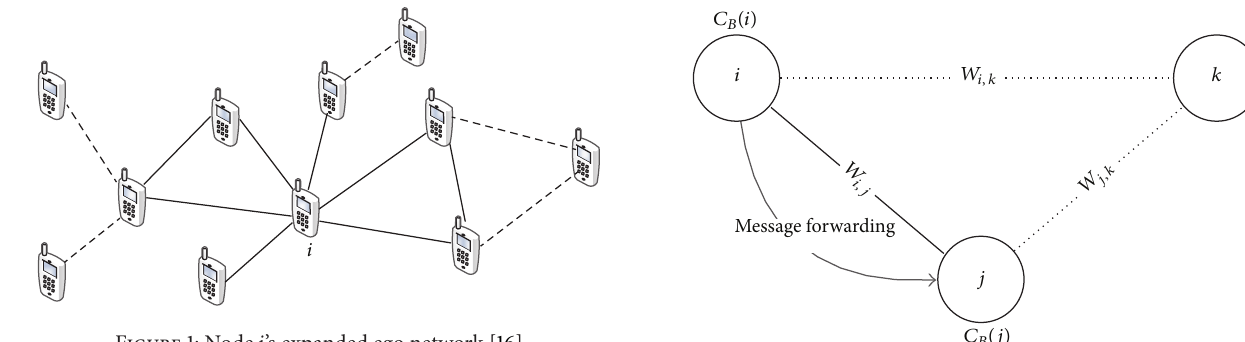
Figure 1: Node 𝑖 ’s expanded ego network [16].